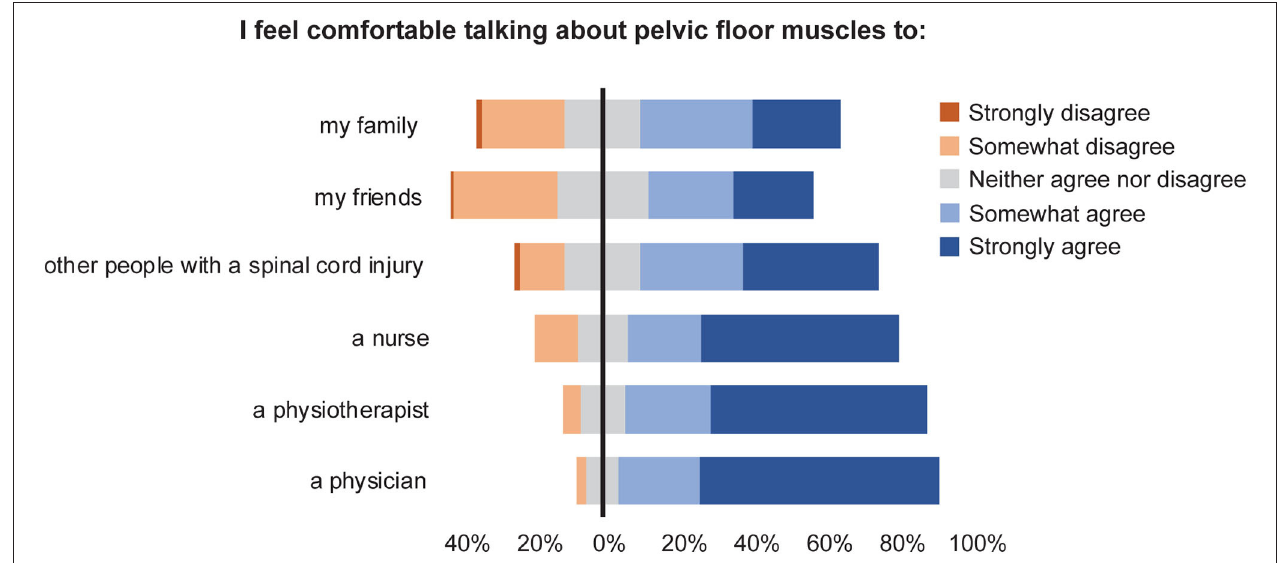
FIGURE 2 | Responses to the question “I feel comfortable talking about pelvic floor muscles to _____” (Attitudes).